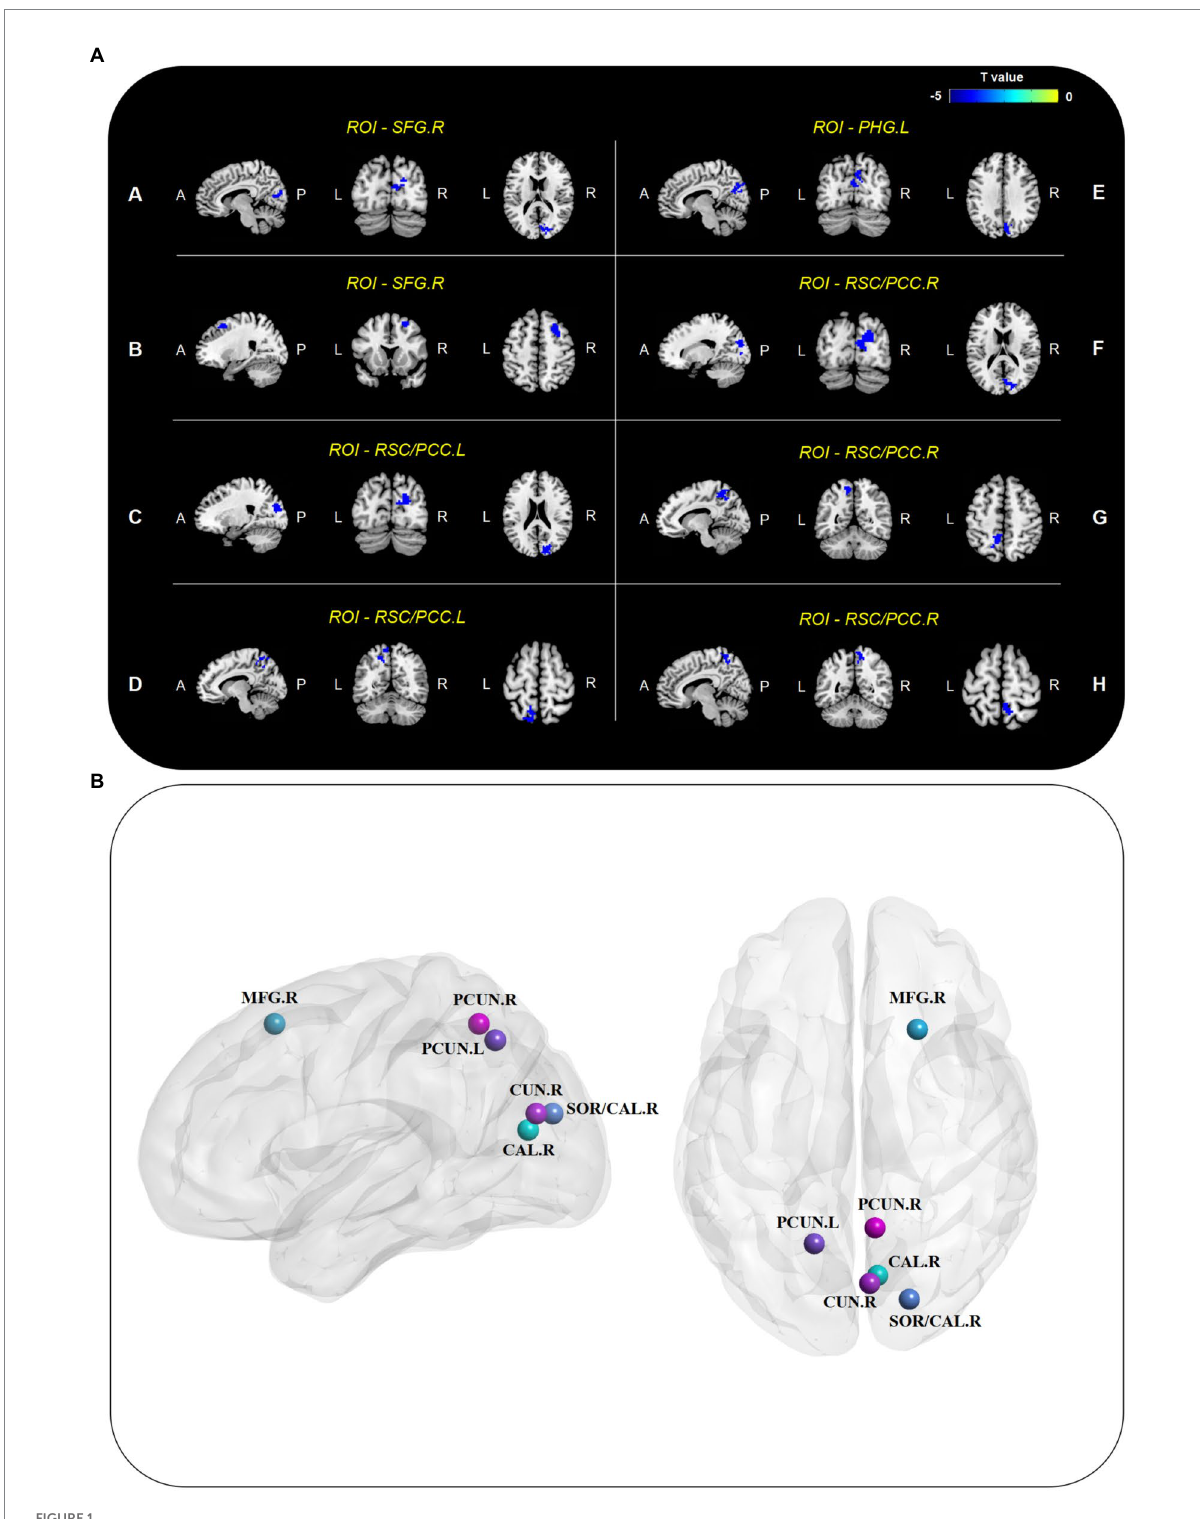
FIGURE 1 Altered seed-based whole-brain FC of DMN. (A) Brain regions with decreased connectivity to DMN core ROIs in the DNR patients compared to the non-DNR patients after adjusting for age, sex, and education duration (cluster p < 0.05, FDR-corrected). (B) Visualized nodes with peak T value of such brain regions. CAL, calcarine; CUN, cuneus; DMN, default mode network; DNR, delayed neurocognitive recovery; FC, functional connectivity; FDR, false discovery rate; MFG, middle frontal gyrus; PCC, posterior cingulate cortex; PCUN, precuneus; PHG, parahippocampal gyrus; ROIs, regions of interest; RSC, retrosplenial cortex; SFG, superior frontal gyrus; SOG, superior occipital gyrus; A, anterior; P, posterior; L, left; R,